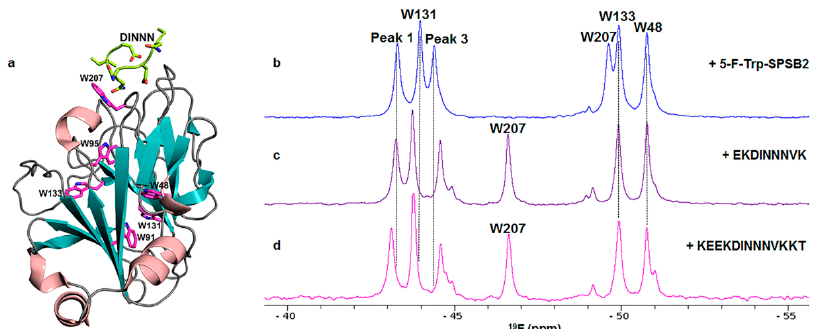
Figure 1. ( a ) Crystal structure of SPSB2 with bound DINNN peptide (PDB id: 3EMW). The six Trp residues of SPSB2 (W48, W91, W95, W131, W133 and W207) are shown in stick representation and coloured magenta. Four Trp resonances were successfully assigned using site-directed mutagenesis, (W48, W131, W133, and W207) but the completely buried W91 and W95 could not be assigned by this means and are labelled as peak 1 or 3. W207 is closest to DINNN; 19 F-NMR spectra of 5-F-Trp-SPSB2 in the absence ( b ) and presence ( c , d ) of 9- and 13-residue peptides containing the key binding epitope from iNOS, DINNN. All 19 F spectra were acquired at 30 °C with 100 μ M 5-F-Trp-SPSB2 in 50 mM sodium phosphate, pH 7.4, 50 mM NaCl, 2 mM EDTA, 2 mM DTT, 0.02% sodium azide. The W207 resonance was significantly perturbed by DINNN-containing peptides, indicating that these peptides target the iNOS binding site [31].